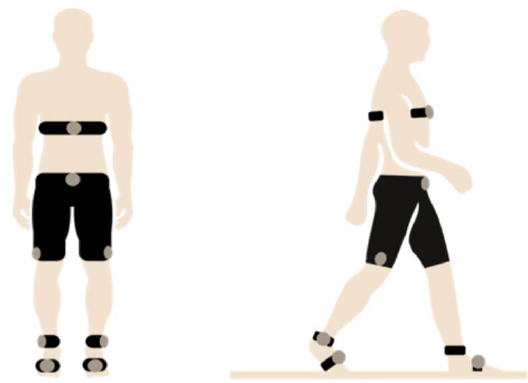
Figure 1. Position of sensors during the test execution.